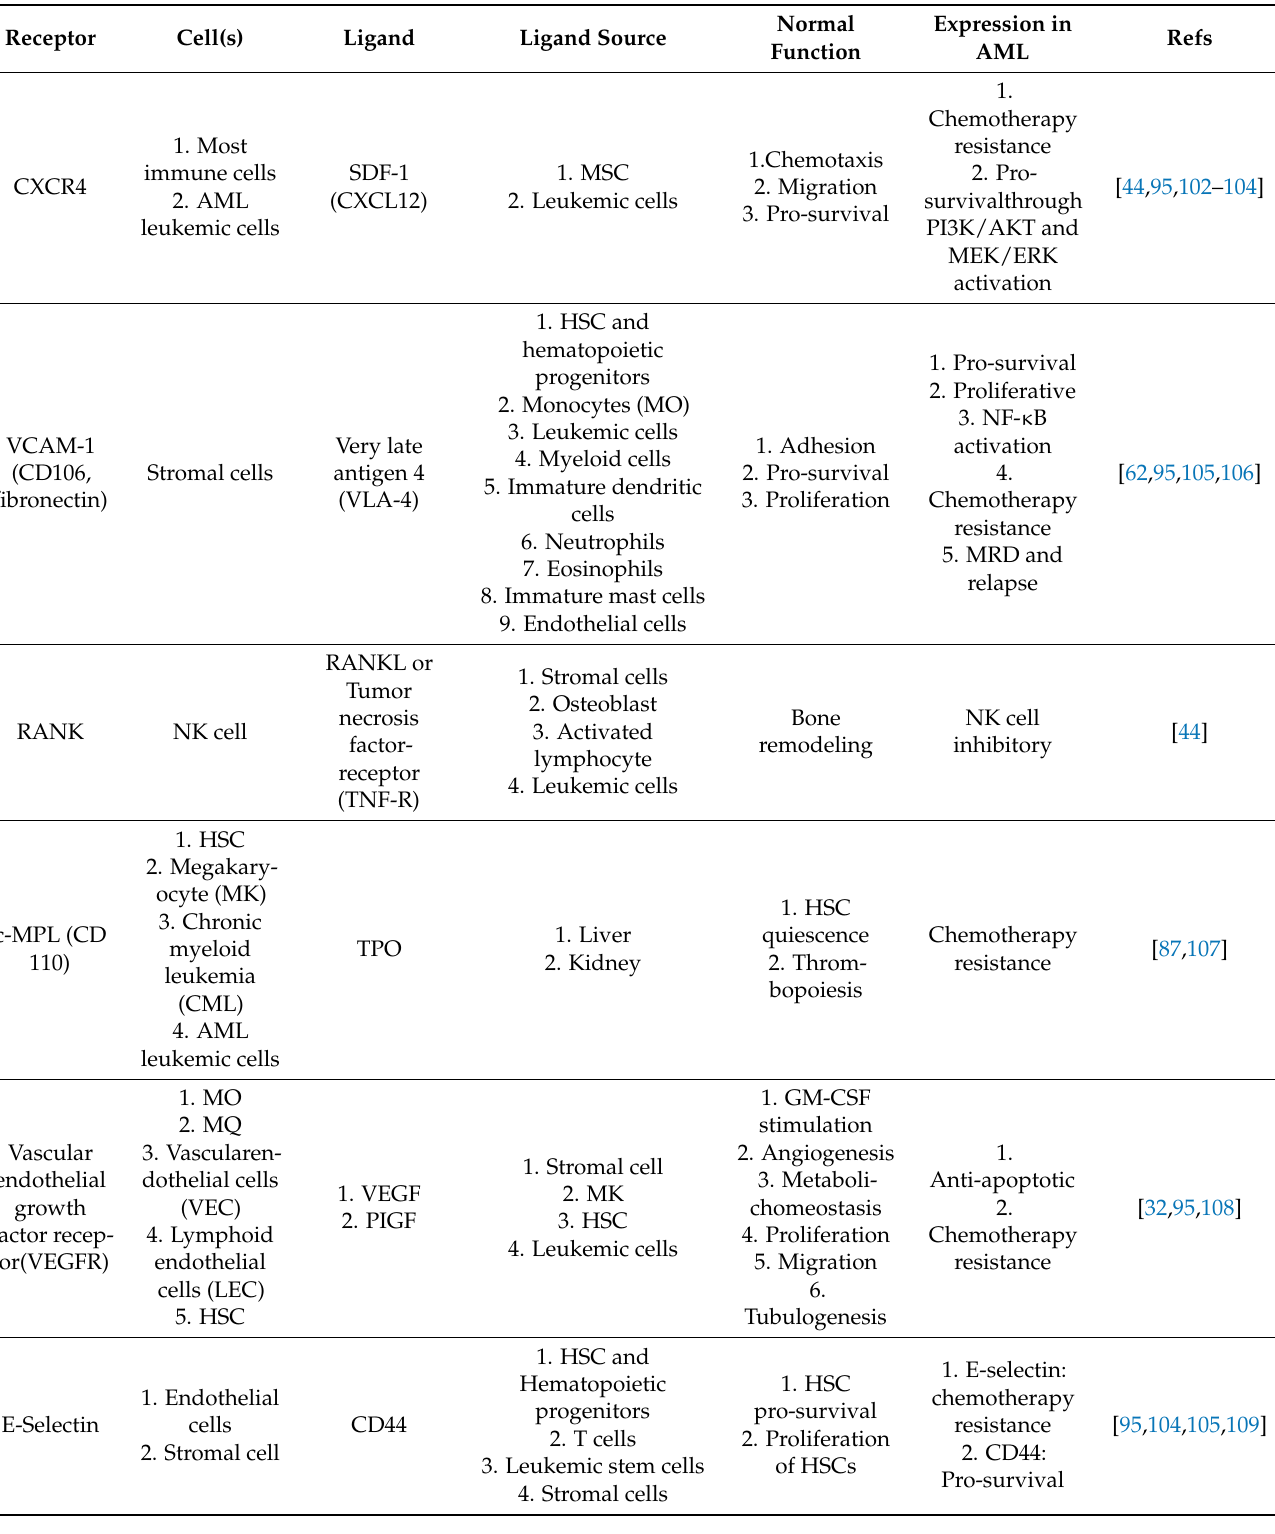
Table 5. BM cytokine and chemokine network interrelationship in